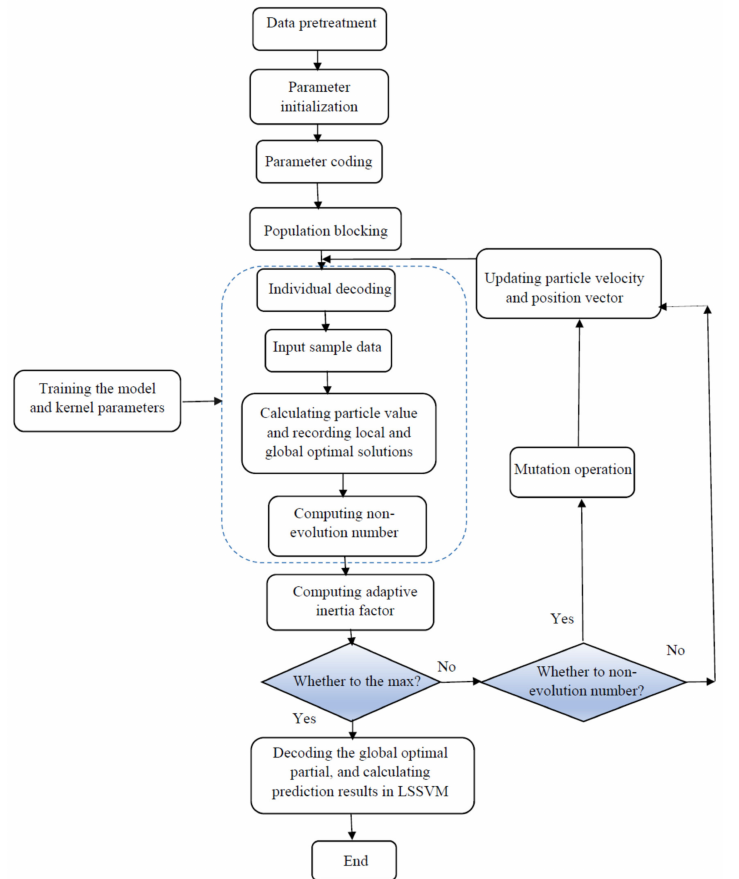
Figure 5. Flowchart of the least square support vector machine—coupled simulated annealing (LSSVM CSA) strategy employed in the current